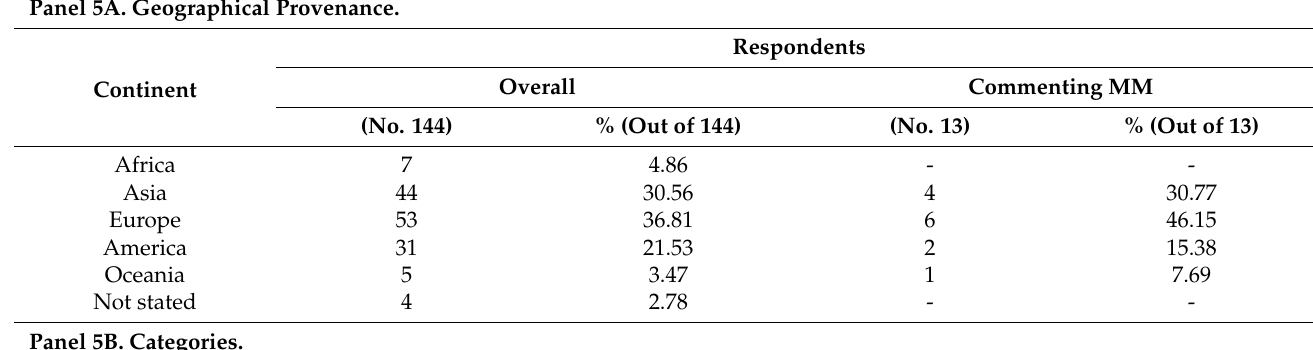
Table 5. Respondents to the 2021 Universal Standards exposure draft: demography. Panel 5A. Geographical